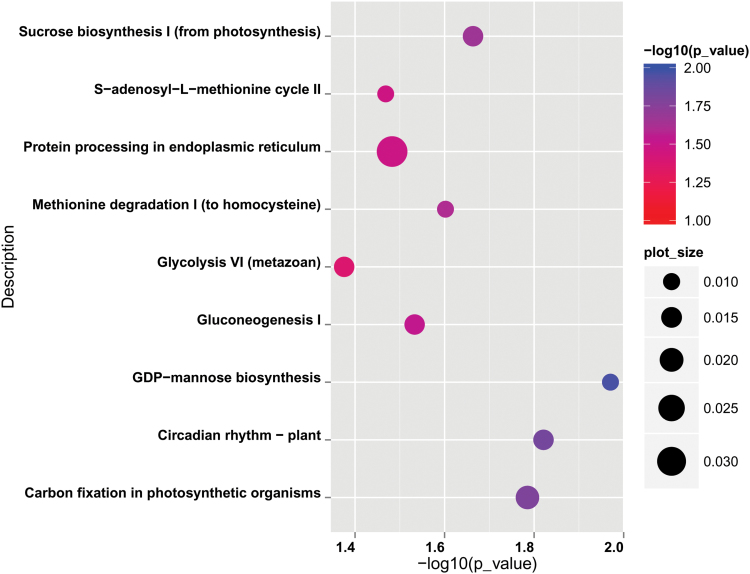
KEGG enrichment of 202 overlapping differential genes between spring and winter ecotypes in rapeseed and Arabidopsis. The enriched pathways are listed on the left. Colors denotes the –log10(P-value). The size of each bubble reflects the ratio of genes enriched in each pathway to 202 genes.